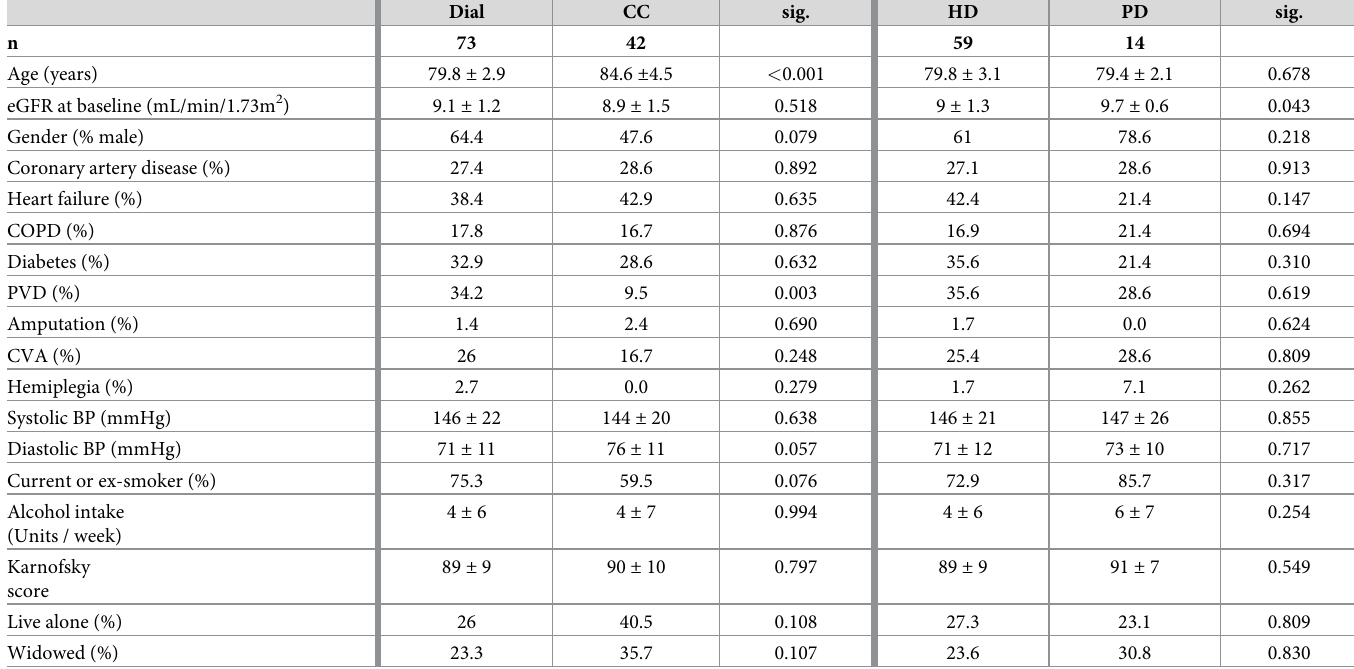
Table 4. Between group comparisons at baseline of first outpatient eGFR � 10 mL/min/1.73m 2 . Key: CC = conservative care group; dial = dialysis group; HD = haemodialysis; PD = peritoneal